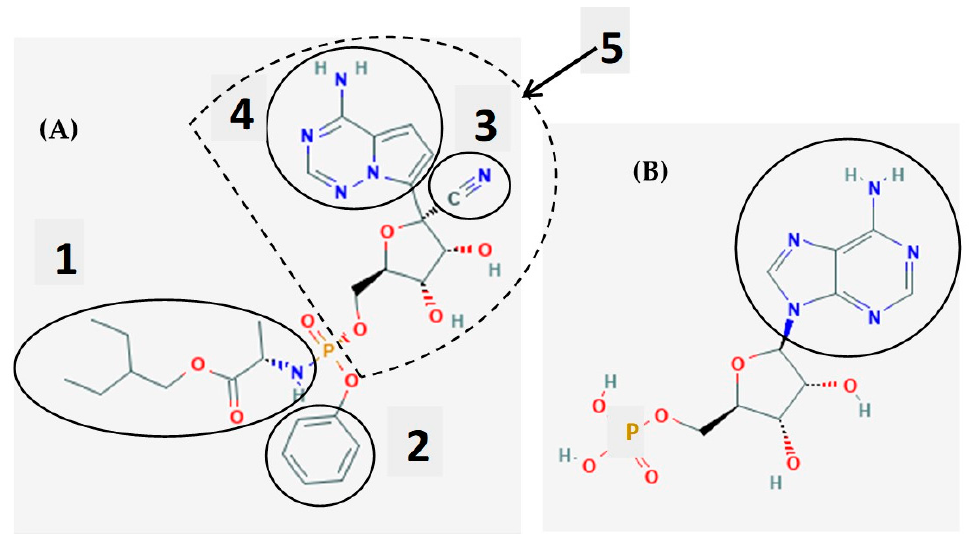
Figure 1. The chemical formula of remdesivir ( A ), adenosine 5 ′ -phosphate ( B ), and of GS-41524